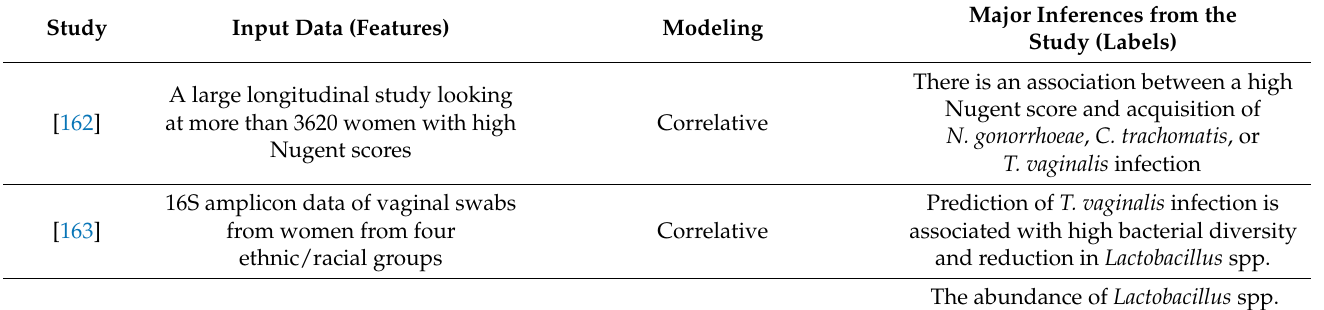
Table 1. Studies carrying out predictive modeling of the female genital